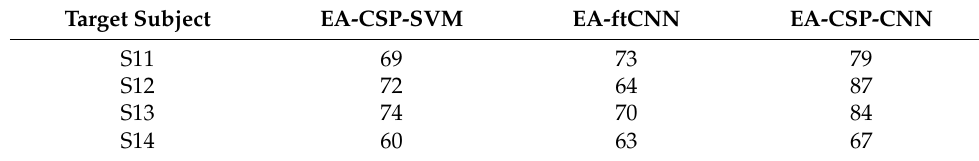
Table 2. Overall classification accuracy